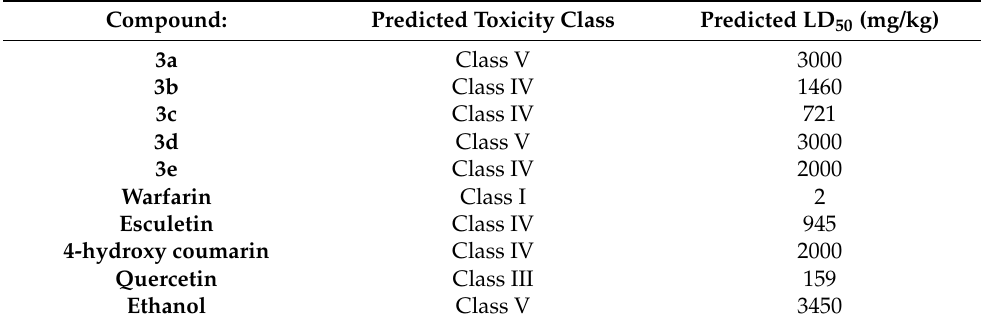
Table 6. Predicted toxicity of the investigated compounds 3a – e with warfarin, esculetin, 4-hydroxy coumarin, quercetin, and ethanol as referent compounds. Compound: Predicted Toxicity